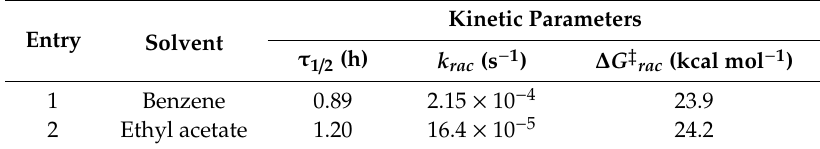
Figure 2. HPLC analysis of hydrazides 2a – c on a chiral stationary phase . (HPLC condition: Figure 2. CHIRALPAK ® IC, mobile phase hexane:2-propanol 70:30, flow rate: 1.0 mL/min, retention times 10.6 min and 20.9 min; 2b CHIRALPAK ® IC, mobile phase-hexane:2-propanol 70:30, flow rate: 0.8 mL/min, HPLC condition; broad peak from 22.4–25.0 min; 2c CHIRALPAK ® AD-H, mobile phase hexane:2- Table 2. Kinetic parameters of racemization barrier for hydrazide 2c a . Table 2. Kinetic parameters of racemization barrier for hydrazide 2c a